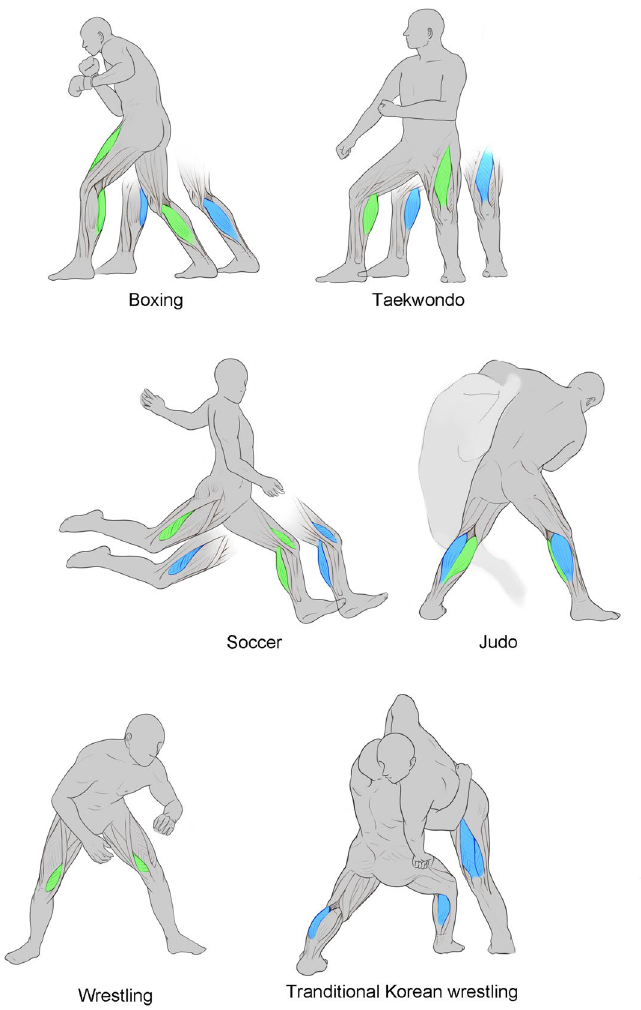
Figure 2. Main muscles involved in reaching for maximum power and mean power in Athletes from different sports categories. Peak power related muscles are indicated in blue color; Mean power related muscles are indicated in green